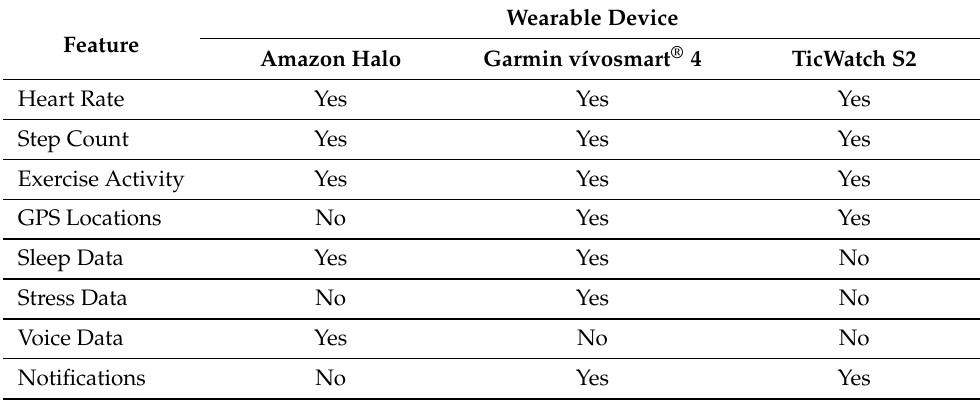
Table 3. Features populated for each wearable